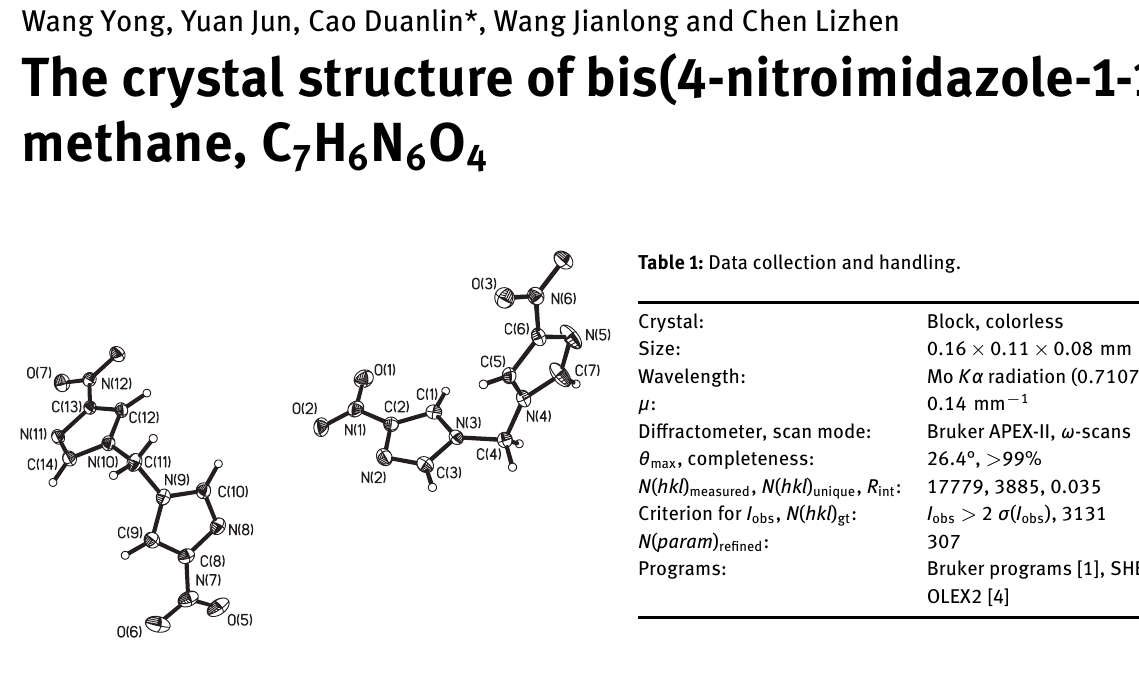
Table 2: Fractional atomic coordinates and isotropic or equivalent isotropic displacement parameters (Å 2